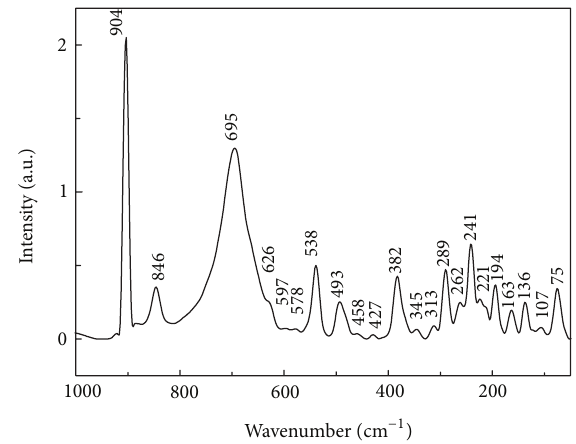
Figure 2: FT-Raman spectrum of the as-prepared CaNb 2 O 6 nano- powder.